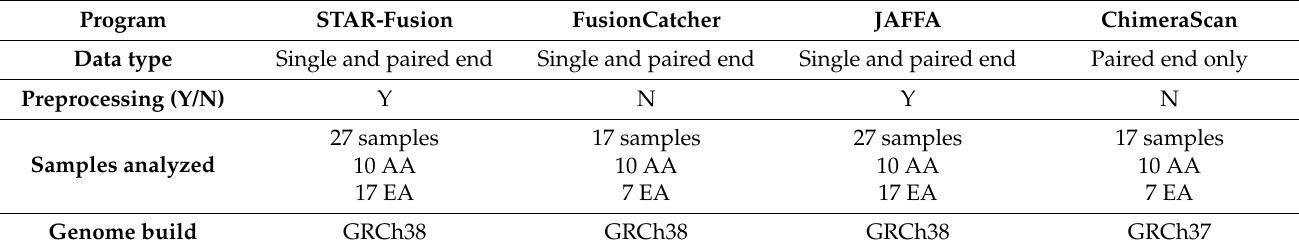
Table 2. Comparison of the input sequencing data, patient samples, and genome build specific to our